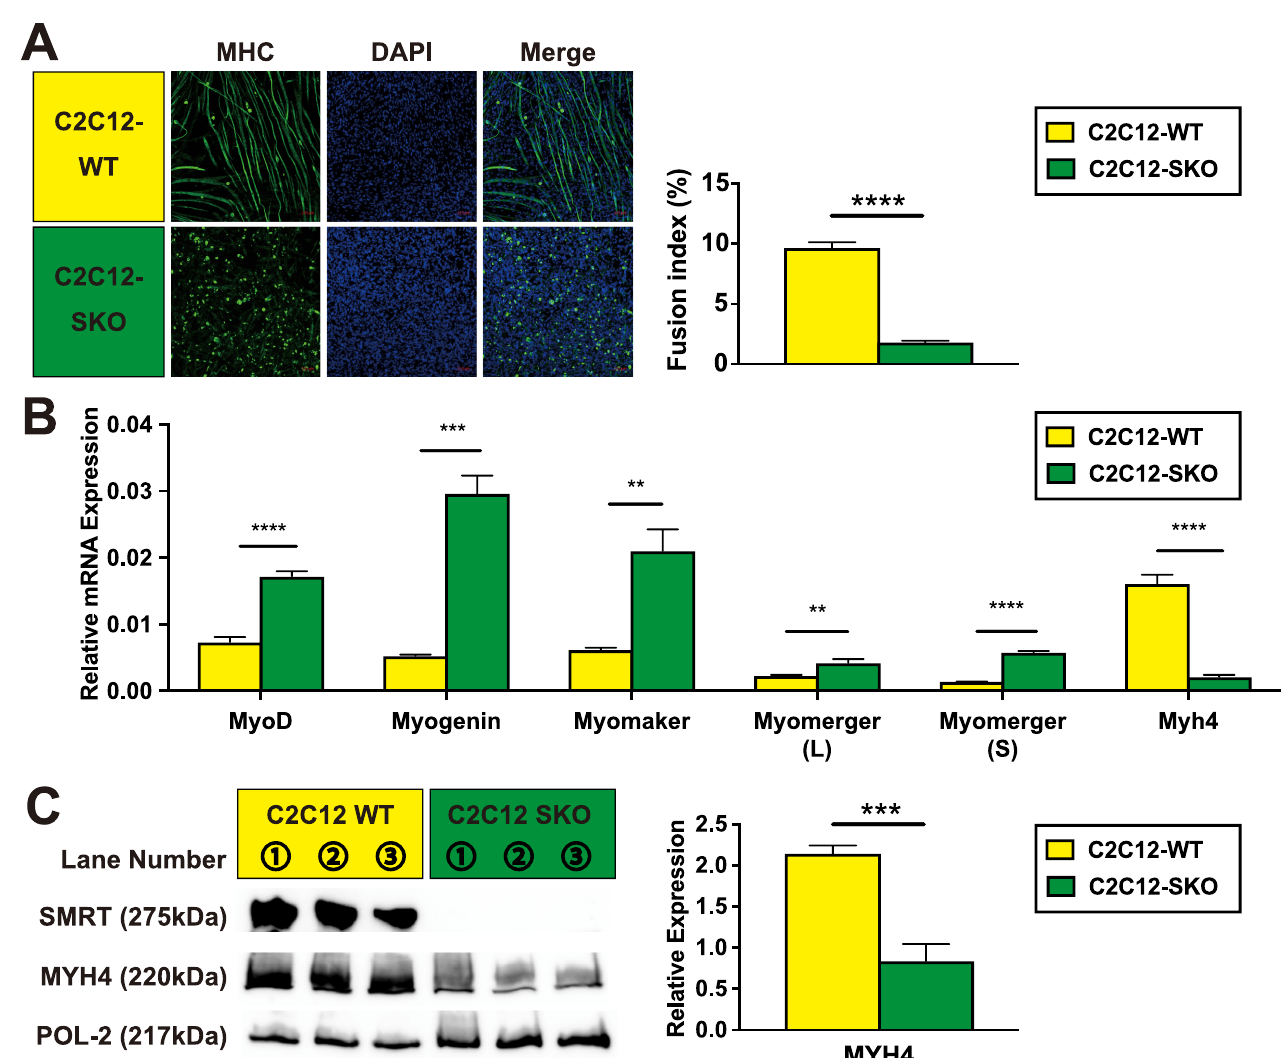
Fig 1. SMRT regulates myotube formation in the differentiation process of C2C12 cells. (A) Both C2C12-WT and C2C12-SKO cells were induced to differentiate in differentiation medium. The expression of myosin heavy chain 4 (MYH4) in both C2C12-WT and C2C12-SKO cells were assessed by IHC. Myotubes were stained by anti-MYH4 antibody (Green). Nuclei were stained by DAPI (Blue). The fusion indexes of the cells were calculated from IHC. (B) mRNA expression of myogenic-related genes in both C2C12-WT and C2C12-SKO cells were quantified by qPCR (n = 3 per group). (C) Protein expression of SMRT and MYH4 in both C2C12-WT and C2C12-SKO cells were assessed by WB (n = 3 per group). Student t-tests were used for statistical analyses in the calculation for fusion index and all qPCR and quantification of protein expression. Results are shown as the mean ± SEM (error bars represent SEM), and the p- value are shown as ���� p < 0.0001, ��� p < 0.001, �� p <